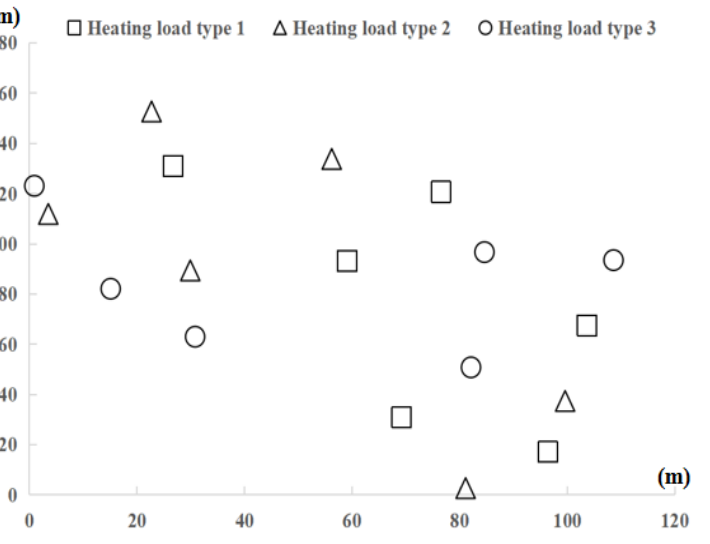
Table 7. The number of clusters in each clustering